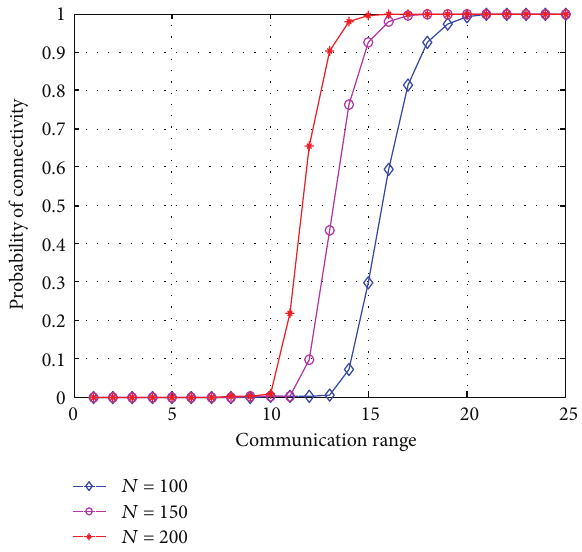
Figure 6: Probabaility of 𝐾 -connectivity versus number of sensor.